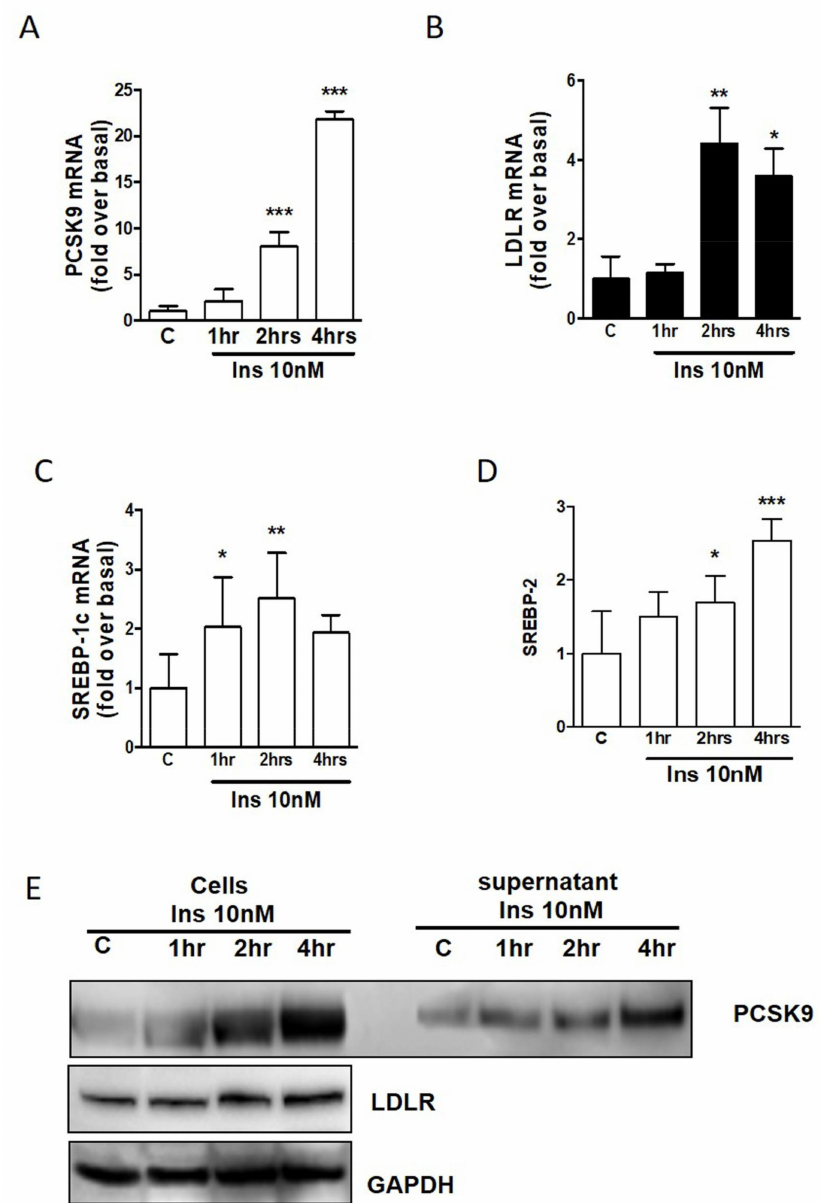
Figure 2. ( A ) PCSK9 induction by insulin in differentiated human adipocytes. ( B ) LDLR induction by insulin in differentiated human adipocytes. ( C ) SREBP-1c induction by insulin in differentiated human adipocytes. ( D ) SREBP-2 induction by insulin in differentiated human adipocytes. ( E ) PCSK9, LDLR, and GAPDH levels after treatment with insulin. * p < 0.05, ** p < 0.01 and *** p < 0.001 vs